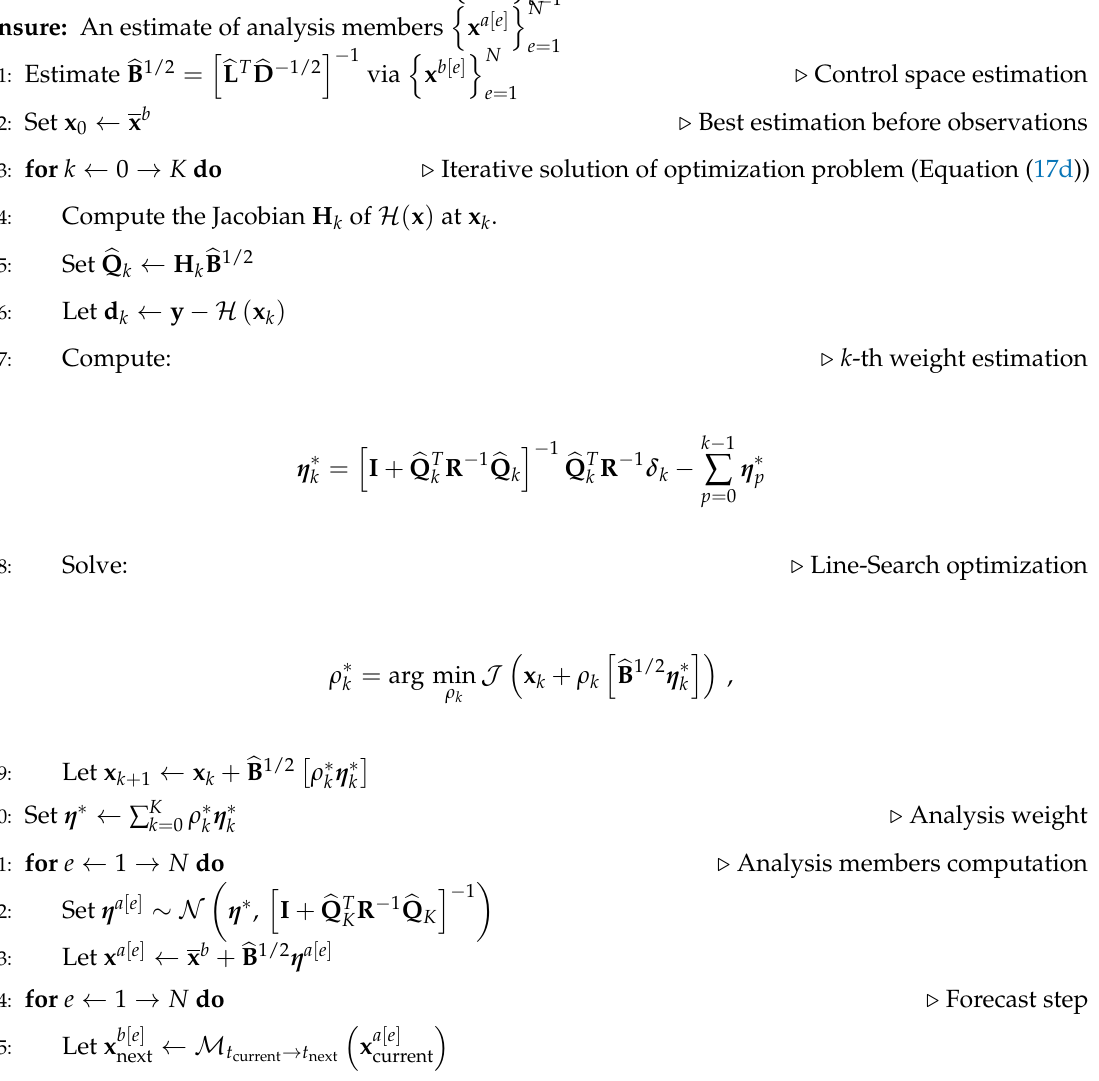
Algorithm 1 Forecasts and Analysis Steps of the